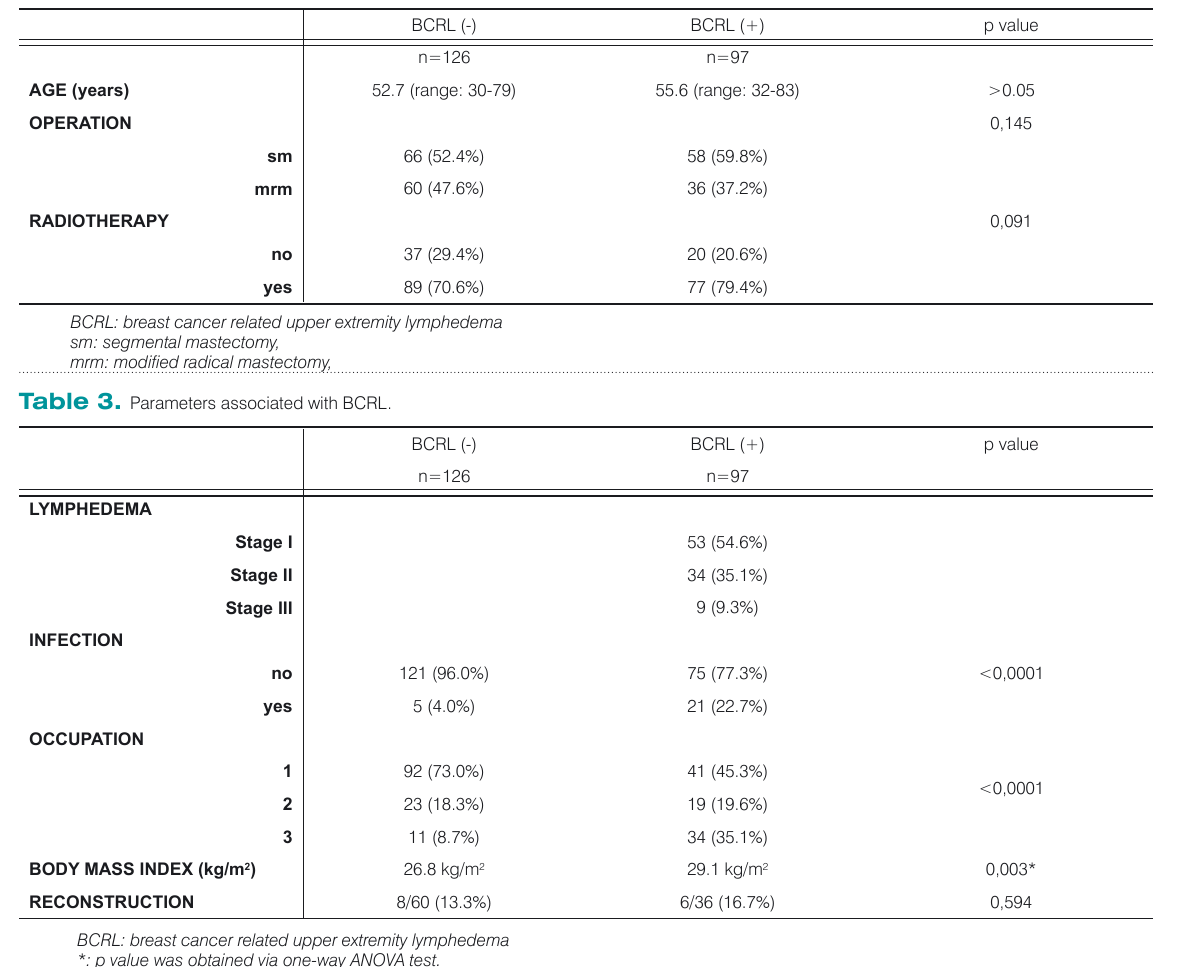
Table 2. Patients’ characteristics.